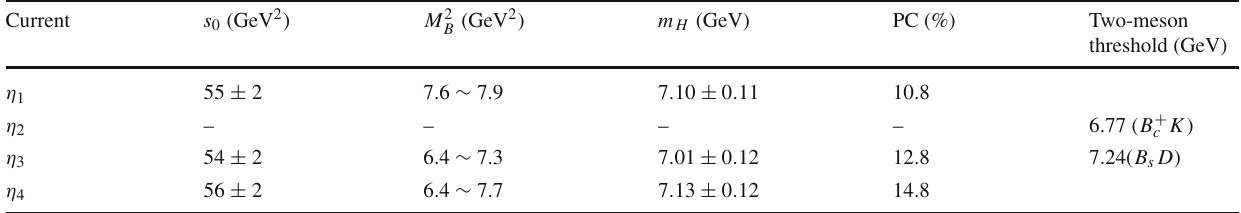
Table 3 The continuum threshold, Borel window, mass and pole contribution for the sc ¯ q ¯ b system with J P = 0 +